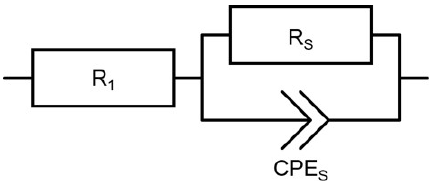
Figure 5. Equivalent circuit diagram for electrochemical impedance spectroscopy.